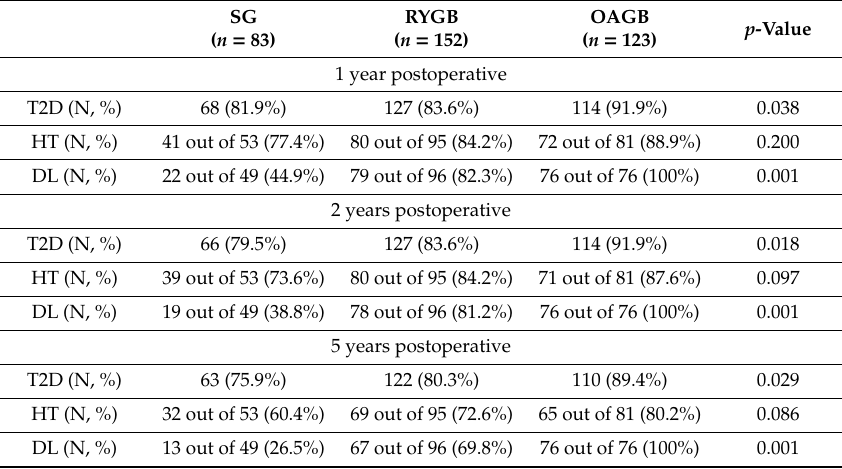
Table 3. Remission of comorbidities between